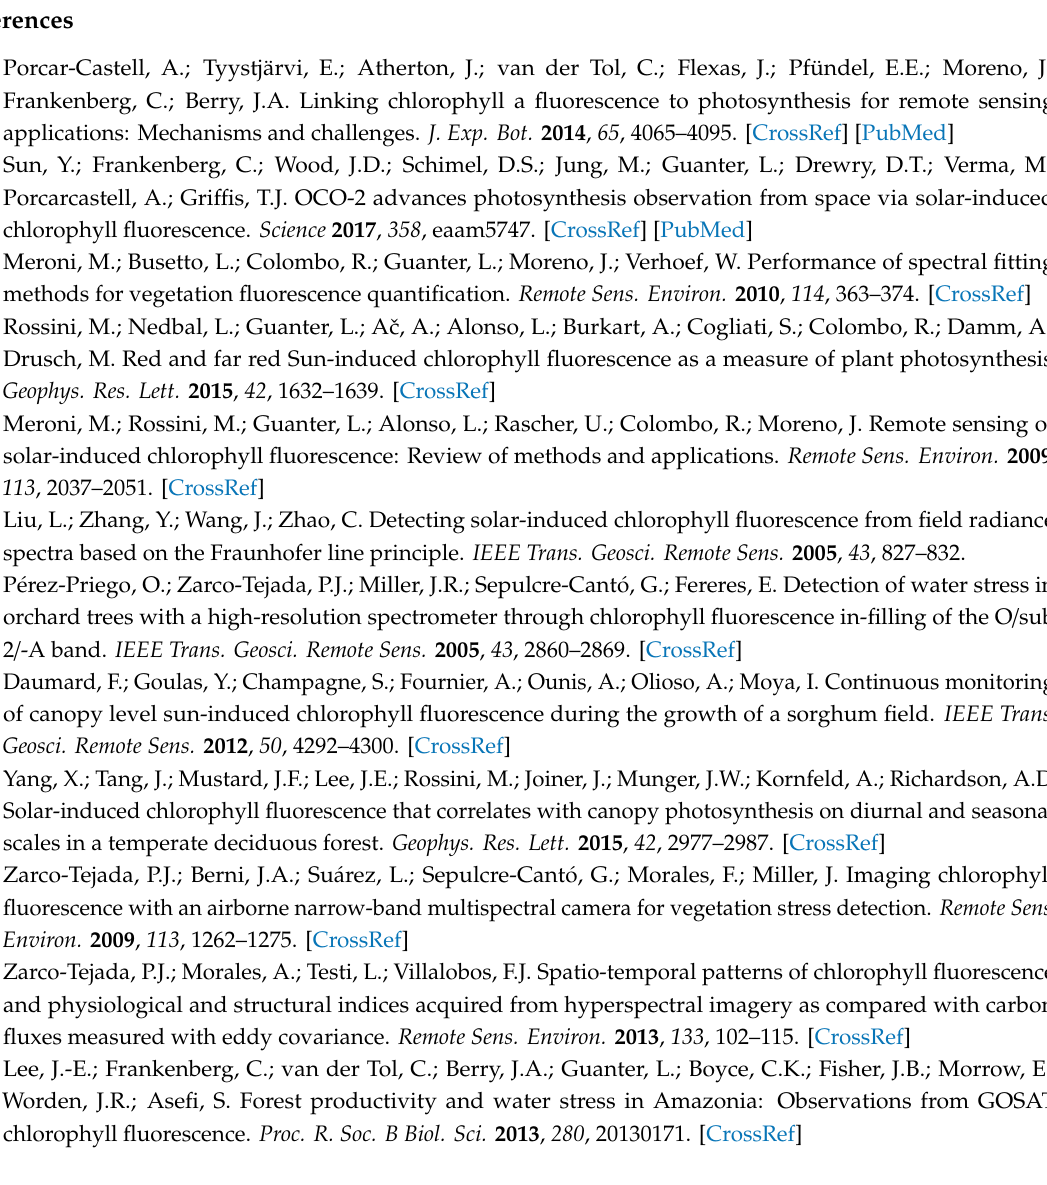
Figure S1: Seasonal patterns of daily F760, AF760 and Fy760 from four plots of maize compared with daily solar radiation (SWR), Figure S2: Relationships of daily environmental parameters with daily F760, AF760 and Fy760, Figure S3: Comparison of average values of seasonal F760 and concurrent SWR, AF760, Fy760 and growth parameters, including LAI, MTA, Chl (SPAD) and RWC from wheat and maize, Figure S4: Comparison of canopy radiance at 685 nm at four plots of